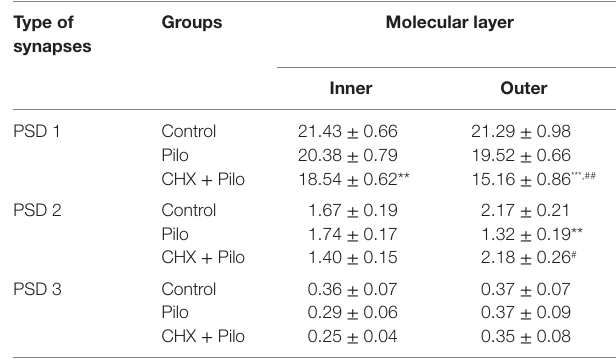
Data expressed as mean ± SEM. ANOVA followed by Newman–Keuls. **P < 0.01, and ***P < 0.001 as compared to controls. # P < 0.05 and ## P < 0.01 as compared to Pilo group. Each group was comprised of five animals; for each animal, six slices were analyzed.